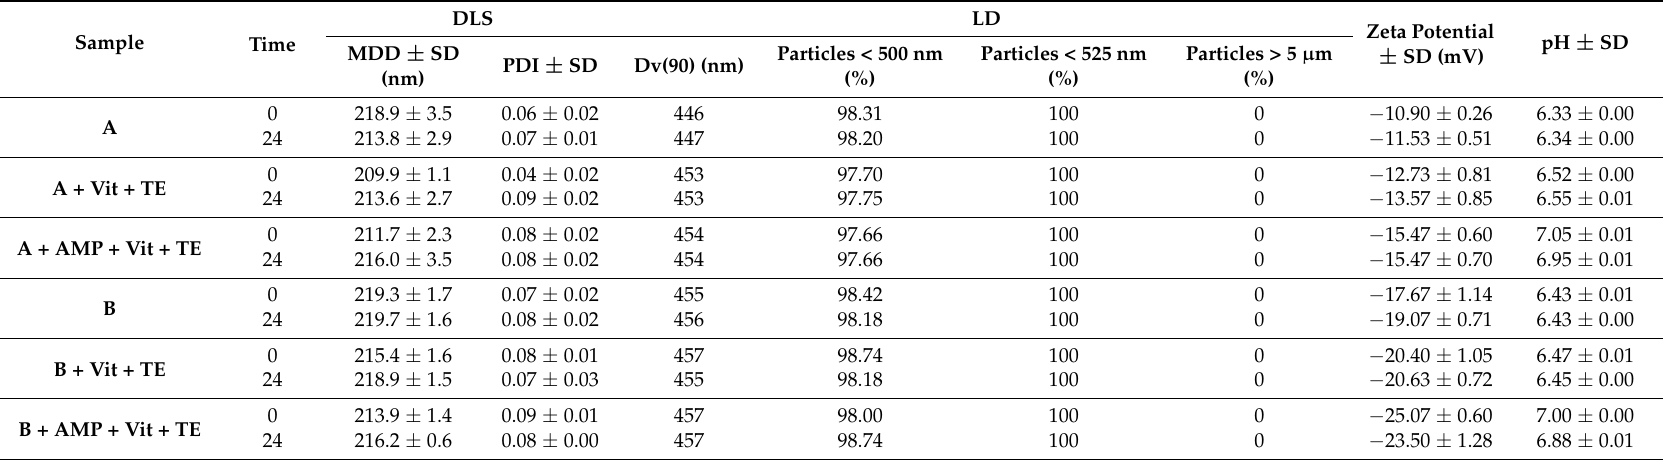
Table 3. Physical characteristics of studied TPN admixtures with vitamins and trace elements. Results are shown as the mean values of three samples ± SD.